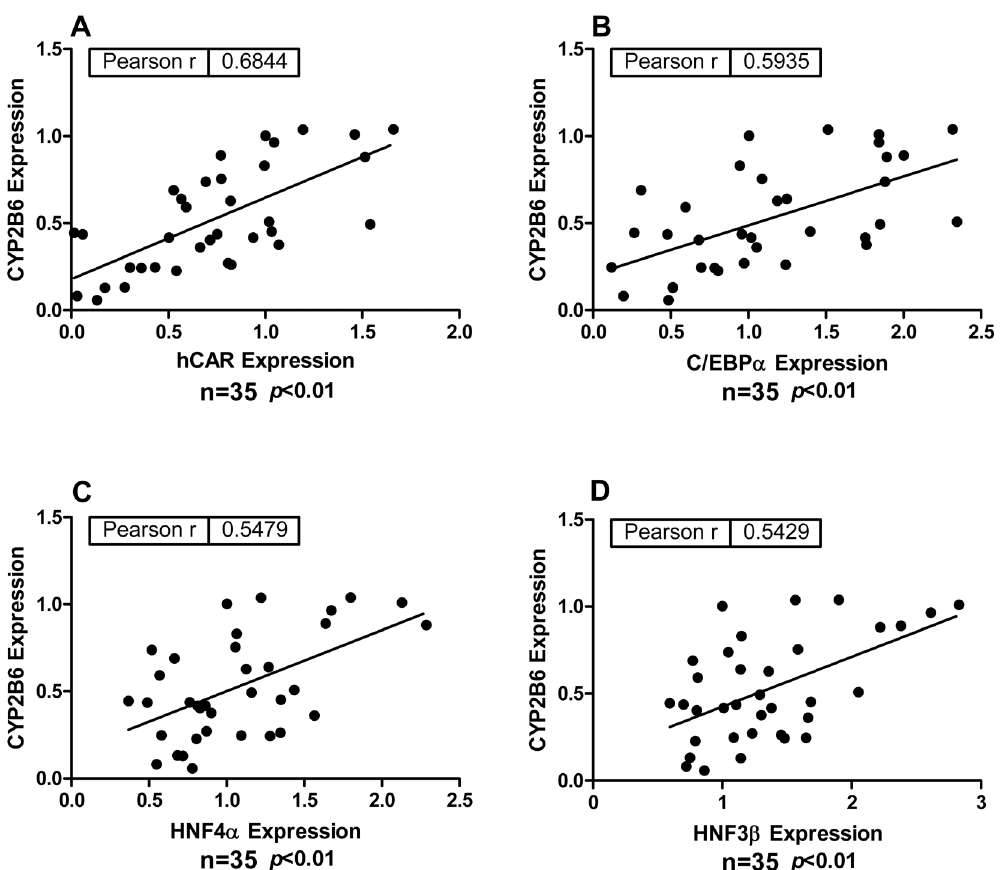
Fig 1. Correlation between CYP2B6 and HNF3 β expression in HPH. Total RNA was extracted from HPHs prepared from 35 human liver donors. Expression levels of CYP2B6, hCAR, C/EBP α , HNF4 α , HNF3 β were measured using real-time RT-PCR assays as detailed in the Materials and Methods . Relative gene expression levels from all donors were normalized against a randomly selected single donor. Leaner regression between CYP2B6 and one of these hepatic transcriptional factors was analyzed individually using Pearson ’ s Correlation Coefficient (JMP 7.0; SAS, NC).